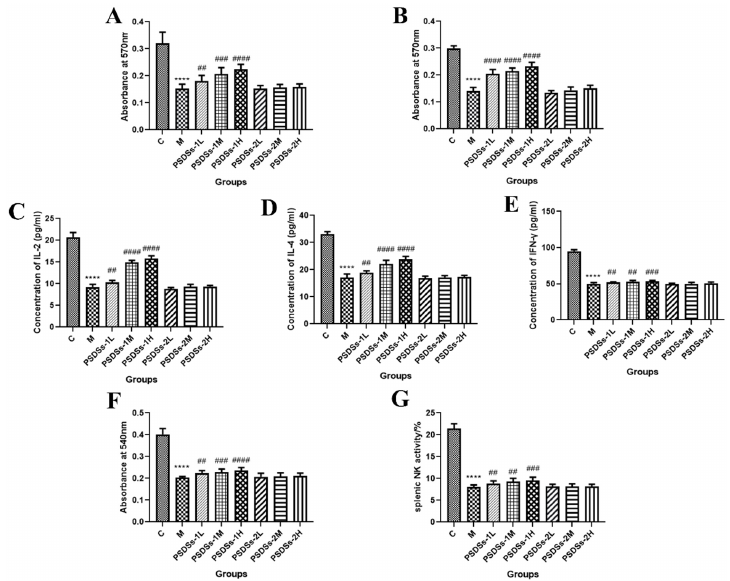
Figure 5. Effects of PSDSs on the proliferation of lymphocytes combined with ConA ( A ) or LPS ( B ). Effect of PSDSs on the secretion of IL-2 ( C ), IL-4 ( D ) and IFN- γ ( E ) induced by spleen lymphocytes in immunosuppressed mice. Effects of PSDSs on the phagocytic activity of peritoneal macrophages ( F ). Effects of PSDSs on splenic NK activity ( G ). n = 8, x ± s. **** p < 0.0001 vs. blank control group; ##